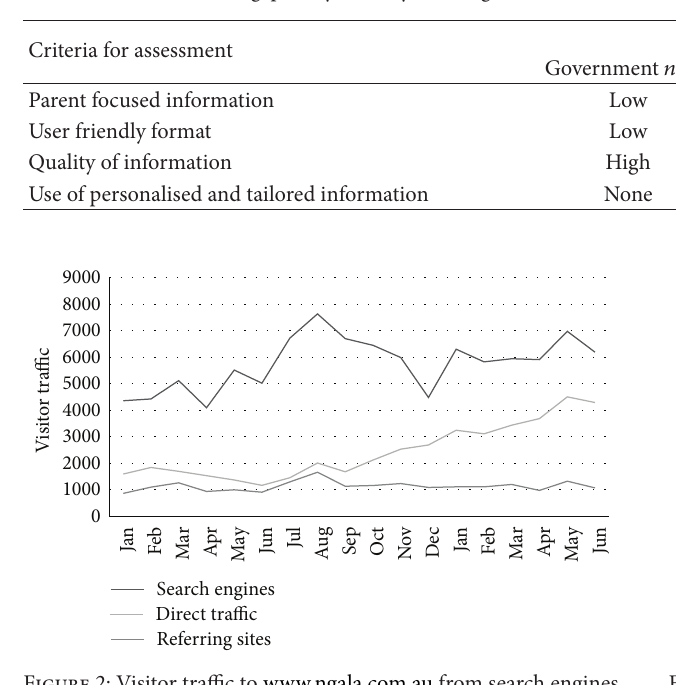
Figure 2: Visitor traffic to www.ngala.com.au from search engines, direct address, and referring sites (January 2012–June 2013).